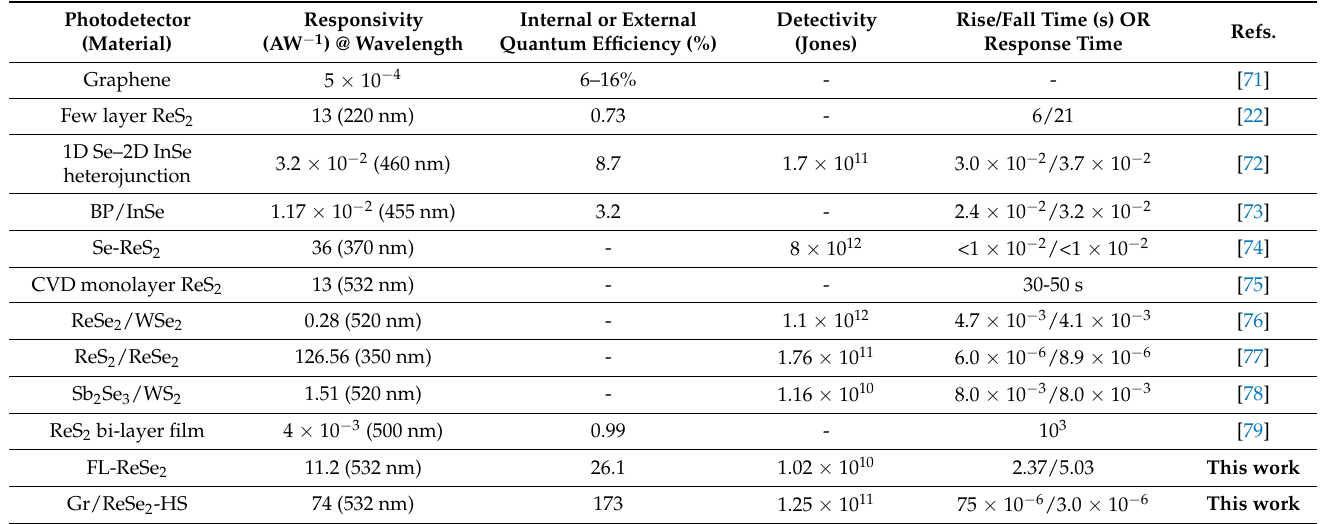
Table 1. Comparison of photodetector performance of as-prepared FL-ReSe 2 and Gr/ReSe 2 -HS with other reports from the